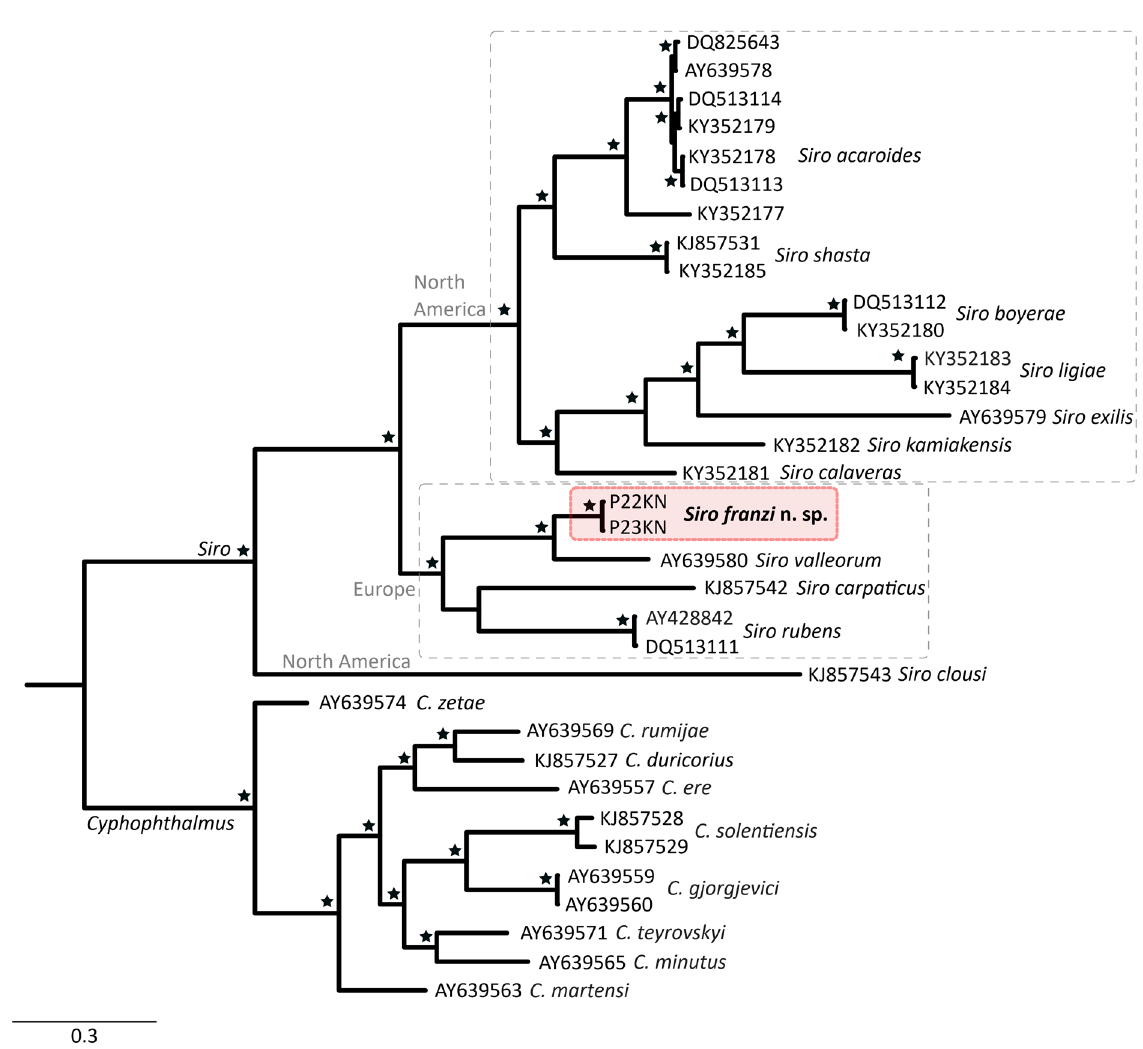
Fig. 3. Bayesian inference topology of the COI dataset (657 bp, 34 taxa) of Siro spp. Posterior probabilities > 90 are indicated as stars and shown close to